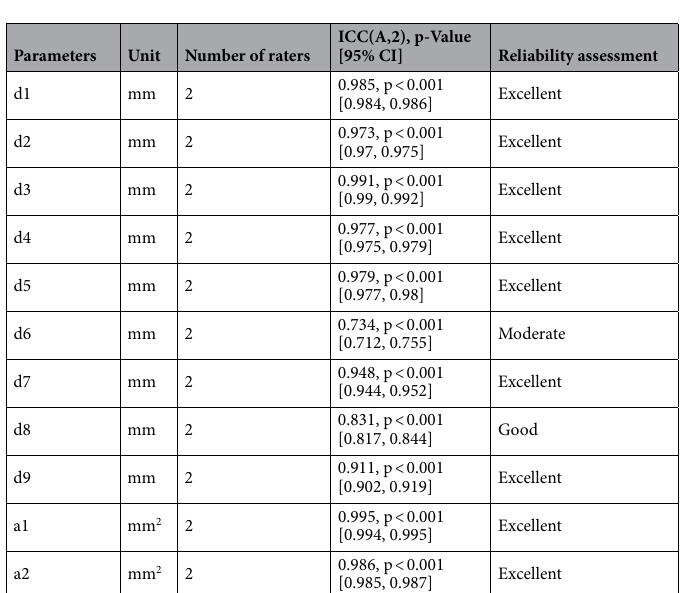
Figure 12. Measurements of cross-sectional dimensions of the spinal cord and locations of the ventral and dorsal horns of human spinal cord. Presented data are based on n = 6 specimens. Solid lines represent the mean and the shaded regions represent the mean ± standard deviation. ( A ) Spinal cord width and height (d1 and d2, respectively in Fig. 7, left) across the lumbosacral cord. ( B ) Cross-sectional areas of the spinal cord and gray matter (a1, a2 in Fig. 7, right) across the lumbosacral cord. ( C ) Mediolateral distances from midline to the dorsal horn boundaries (d5, d8 in Fig. 7, middle). ( D ) Mediolateral distances from midline to the ventral horn boundaries (d3, d9 in Fig. 7, middle). ( E ) Depth from the dorsal surface of the spinal cord of the ventral and dorsal horn boundaries (d4, d7, d6, in Fig. 7, middle).